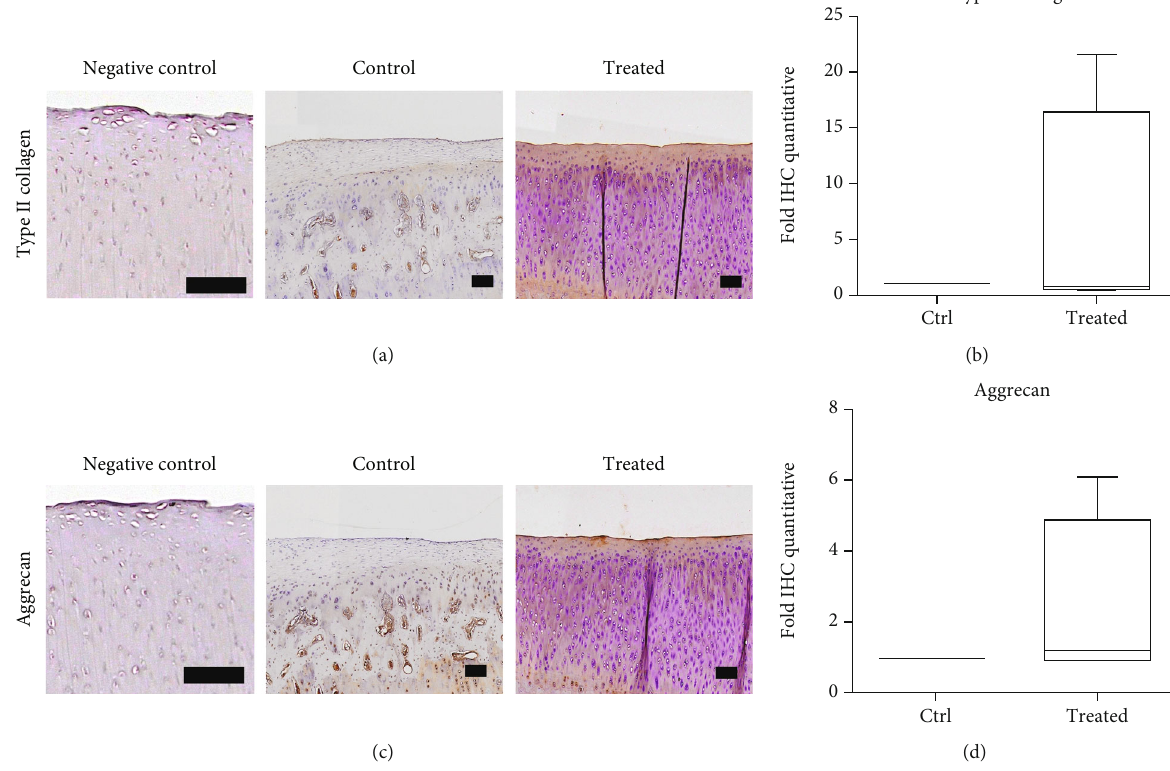
Figure 6: Immunohistochemistry of type II collagen and aggrecan of the cartilage after 12 weeks of experiments. (a) Representative image of type II collagen in the cartilage of normal cartilage (negative control), normal saline control, and HUCMSC+HA-treated knee. Scale bar = 100 μ m . (b) The 1 × 10 7 HUCMSC+HA-treated joints show no signi fi cantly higher content of type II collagen than the normal saline control joints ( n = 4 ). (c) Representative image of aggrecan in the cartilage of normal cartilage (negative control), normal saline control, and treated knee. Scale bar = 100 μ m . (d) The 1 × 10 7 HUCMSC+HA-treated joints show no signi fi cantly higher content of aggrecan than the normal saline control joints ( n = 4 ). No statistical di ff erences are noted between both groups. Ctrl: